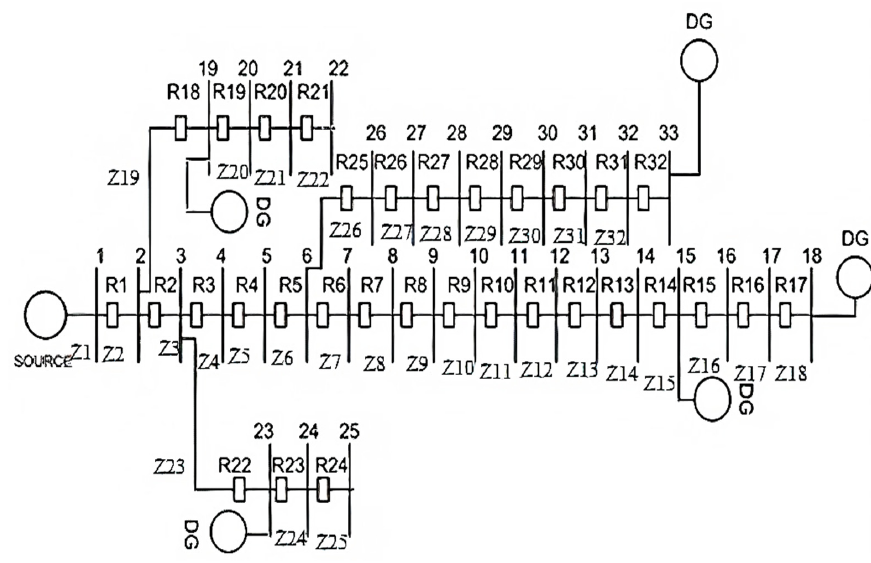
Figure 1. Proposed adaptive and non-adaptive hybrid protection scheme for dynamic relay opera- tion.